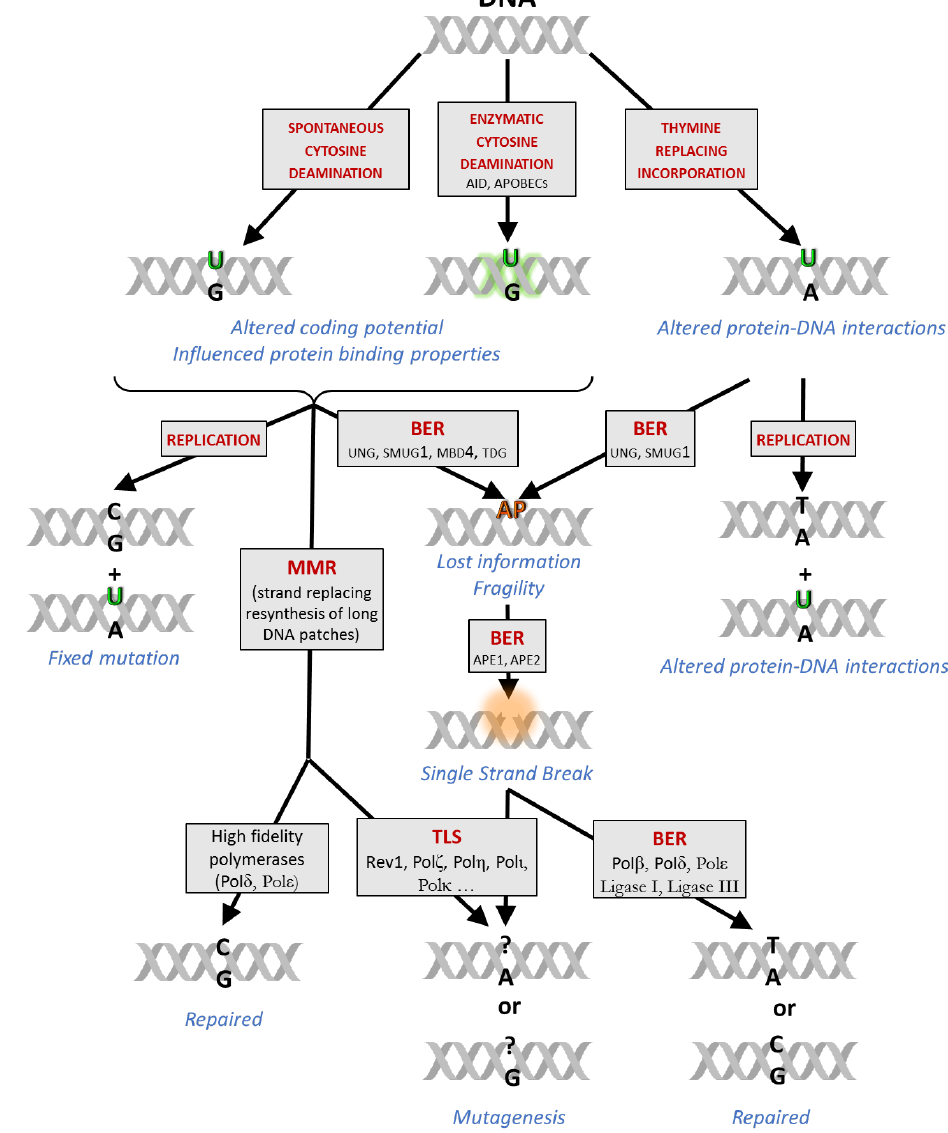
Figure 1. Sources and effects of genomic uracil involving distinct repair mechanisms. Different processes (red letters in grey boxes) are shown with the most important enzymes involved (black letters in grey boxes). Possible consequences of the different outputs are also indicated (blue). Uracil in DNA can arise by spontaneous or enzymatic deamination of cytosines, and by thymine-replacing incorporation. Without repair, U:G mispairs due to cytosine deamination events lead to point mutations right after the next replication, because cytosine and uracil (or thymine) have different base pairing abilities hence different coding potential. Cytosine deamination or the resulted point mutations as well as the “innocent” thymine-replacing uracils (resulted in uracil:adenine (U:A) pairs) can potentially influence interactions between DNA and different DNA binding proteins (such as transcription factors, or polymerases). Uracils can be repaired via base excision repair (BER) initiated by the uracil-DNA-glycosylases: the major enzyme is the uracil-DNA N-glycosylase (UNG); a potential backup is the single-strand selective monofunctional uracil-DNA-glycosylase (SMUG1), while the thymine–DNA–glycosylase (TDG) and the methyl-CpG-binding domain protein 4 (MBD4) can only excise uracils from U:G mispairs. The resulting apyrimidinic/apurinic sites (AP) can be further processed by the AP endonucleases (APE1, APE2). The resulted gap (orange transparent cloud at the single-stranded DNA (ssDNA) break) can be filled correctly by the classic BER polymerases (pol β , δ , and ε ) or in error-prone manner by translesion synthesis (TLS) polymerases (Rev1, pol ζ , η , ι , κ , . . . ). The U:G mispairs can be repaired by the mismatch repair (MMR) as well, which involves re-synthesis of long DNA strands usually by high fidelity but sometimes by error-prone polymerases. Both repair processes could result in either mutagenesis or correct repair depending on the recruited polymerases. In a cell, these different steps and ways of repair might occur simultaneously, and their contribution is also influenced by the actual cell cycle phase, the amount of genomic uracils, or the availability of all of these repair